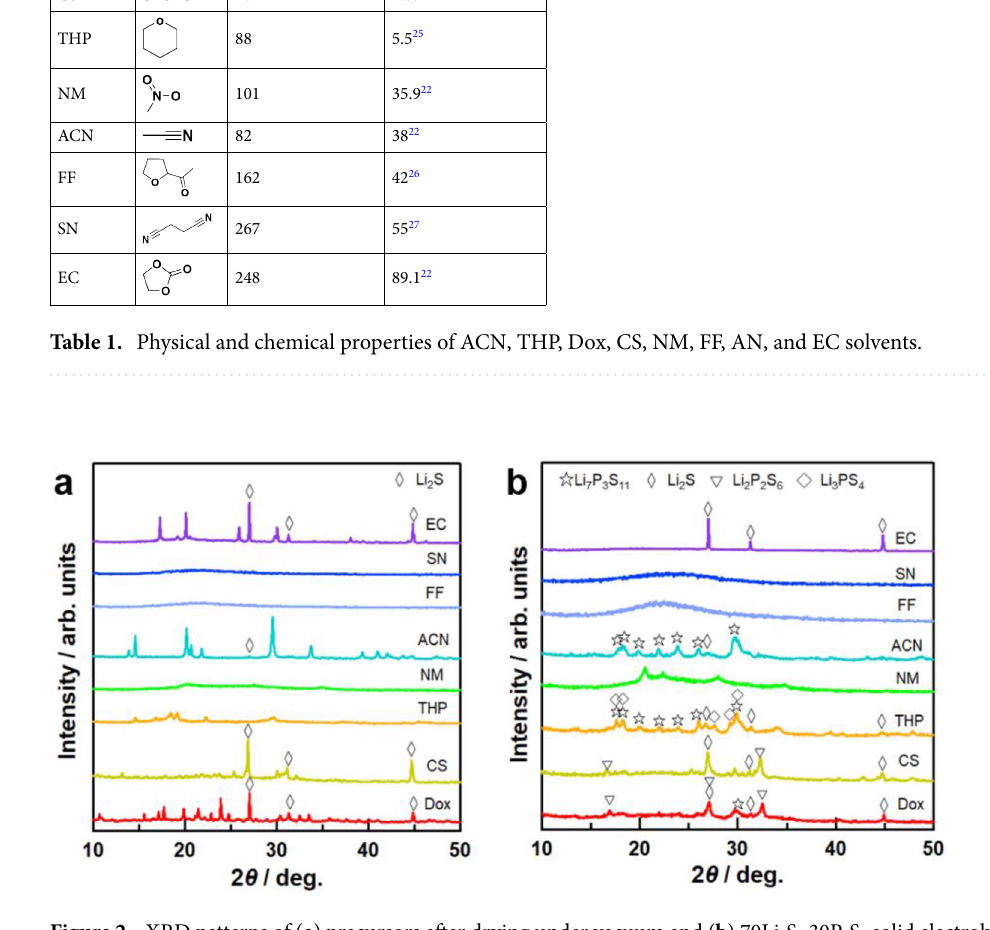
Figure 2. XRD patterns of ( a ) precursors after drying under vacuum and ( b ) 70Li 2 S–30P 2 S 5 solid electrolytes synthesized using each